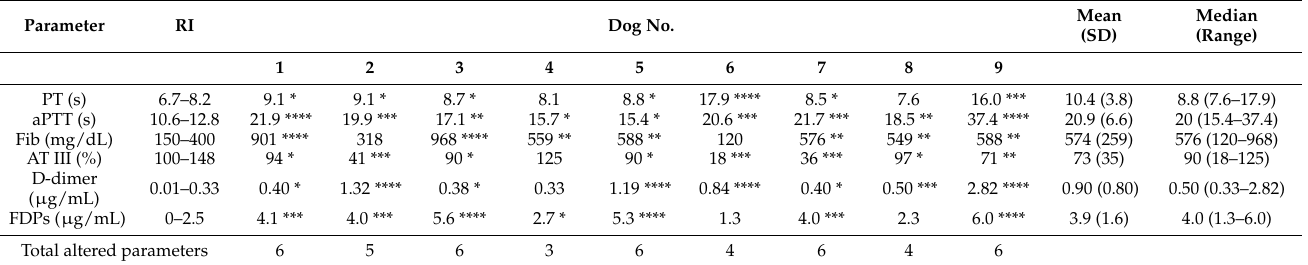
Table 4. The coagulation parameter results and the degree of alteration for nine puppies affected by